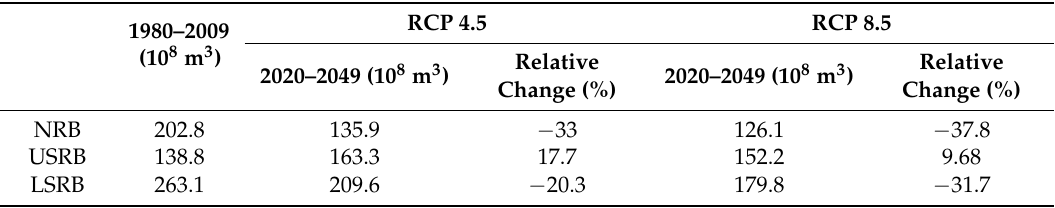
Table 6. Changes of annual water yield during 2020–2049 under future climate senarios (RCP 4.5 and RCP 8.5) in the Songhua River Basin.